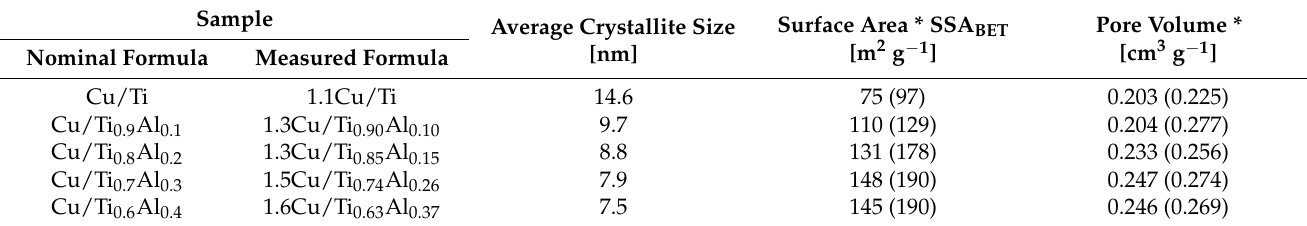
Table 1. Composition, average crystallite size, and textural properties of Al-titania supported copper catalysts.